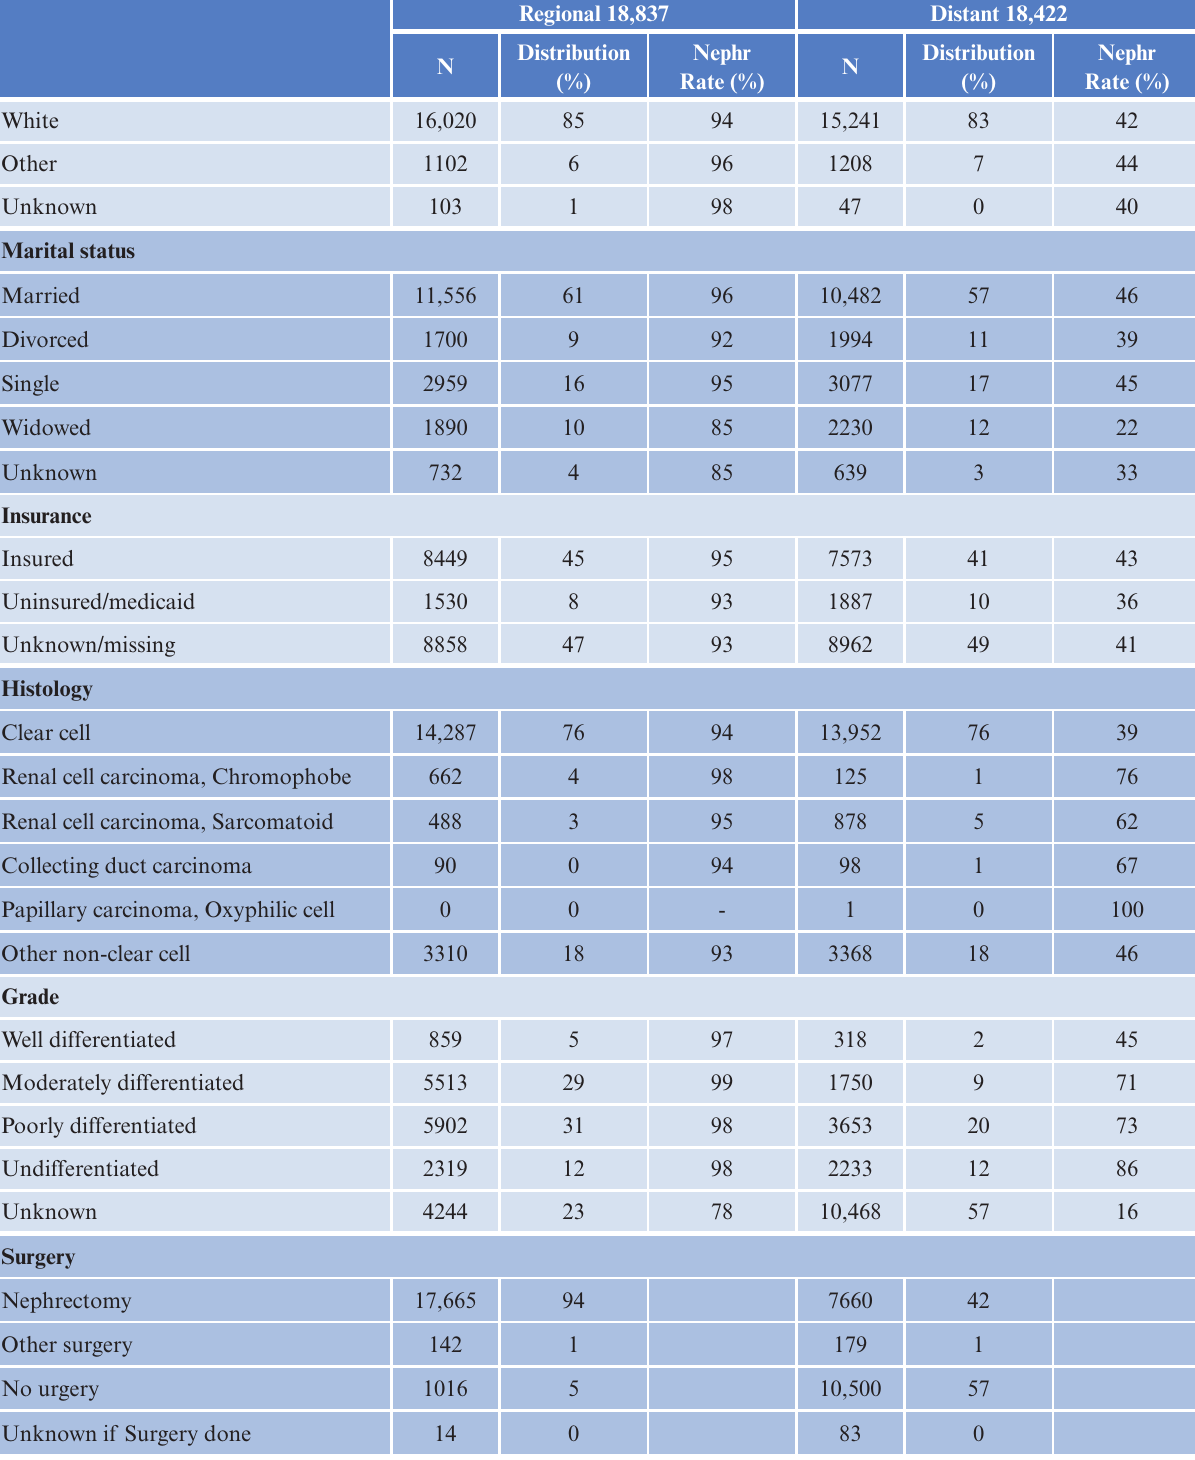
Table 1 (Continued): Population Characteristics and Nephrectomy Rates of All SEER Kidney Cancer, Regional or Distant Stage: